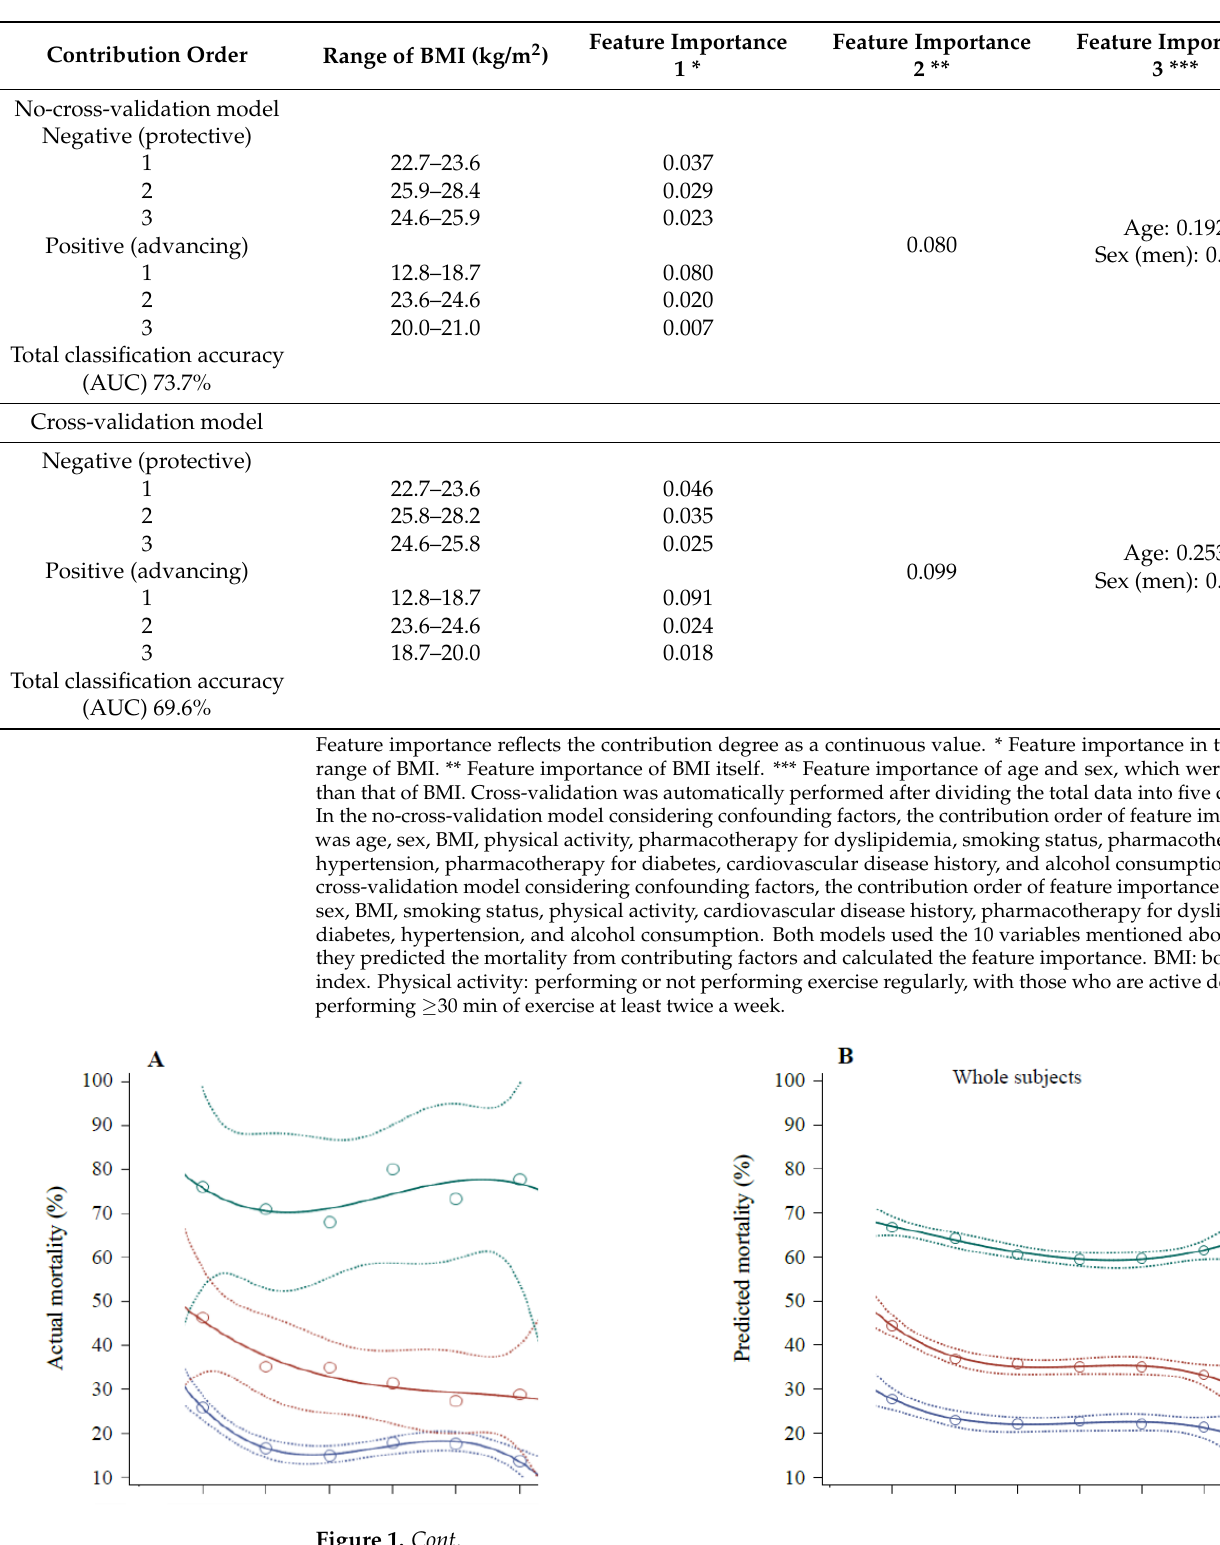
Figure 1. Mortality rates over the eight years according to BMI categories and age groups. ( A ) Actual mortality rates of all participants. This percentage was calculated as follows: number of deaths/num- ber of baseline participants in each BMI category × 100. The numbers of participants in each BMI category were 364, 667, 833, 751, 500, and 338 in the 67–79-year-old category; 278, 468, 525, 424, 275, and 156 in the 80–89-year-old category; 25, 31, 25, 15, 15, and 9 in the 90–104-year-old category. ( B ) Predicted mortality rates of all participants based on the predicted mortality for individuals. The numbers of participants in each BMI category were the same as those mentioned in panel ( A ). ( C ) Predicted mortality rates in male participants based on the predicted mortality for individuals. The numbers of participants in each BMI category were 127, 275, 350, 373, 243, and 113 in the 67–79-year- old category; 111, 186, 231, 206, 132, and 55 in the 80–89-year-old category; 8, 15, 11, 4, 5, and 4 in the 90–104-year-old category. ( D ) Predicted mortality rates in female participants based on the pre- dicted mortality for individuals. The circles and broken lines show the means and 95% CIs. The numbers of participants in each BMI category were 237, 392, 483, 378, 257, and 225 in the 67–79-year- old category; 167, 282, 294, 218, 143, and 101 in the 80–89-year-old category; 17, 16, 14, 11, 10, and 5 in the 90–104-year-old category. The lines and circles were made using SAS software. Body mass index (kg/m 2 )